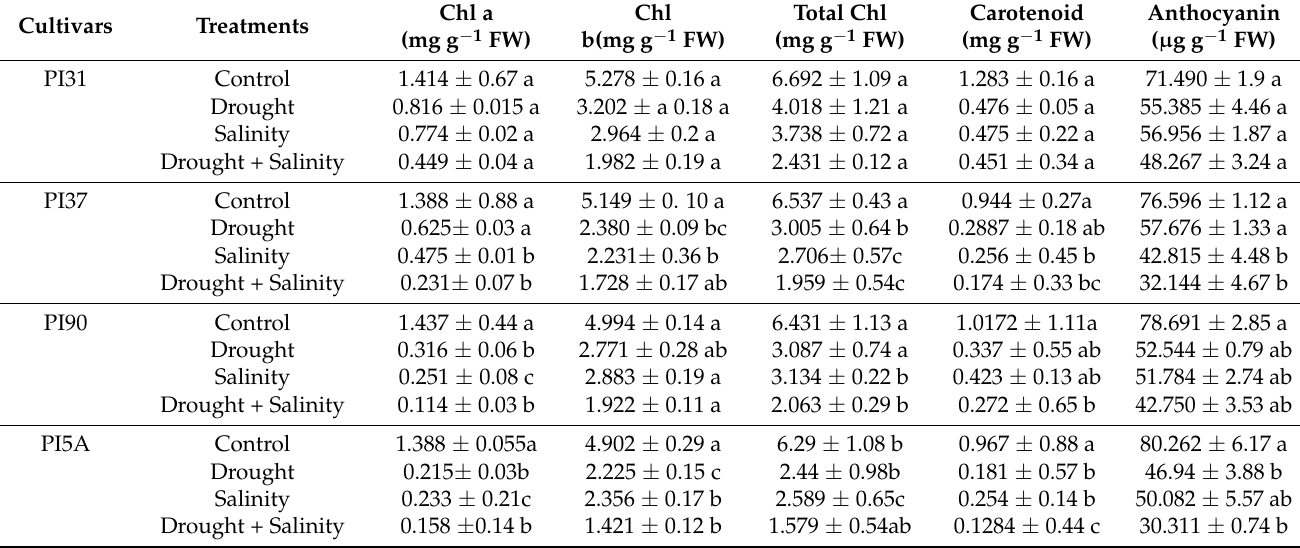
Table 3. Leaf chlorophyll pigments, carotenoid contents, and anthocyanin contents of four soybean cultivars grown under drought and salinity stress conditions. Data presented are means ± SD, and different letters denote a significant difference at p < 0.05 based on the least significant difference (LSD)